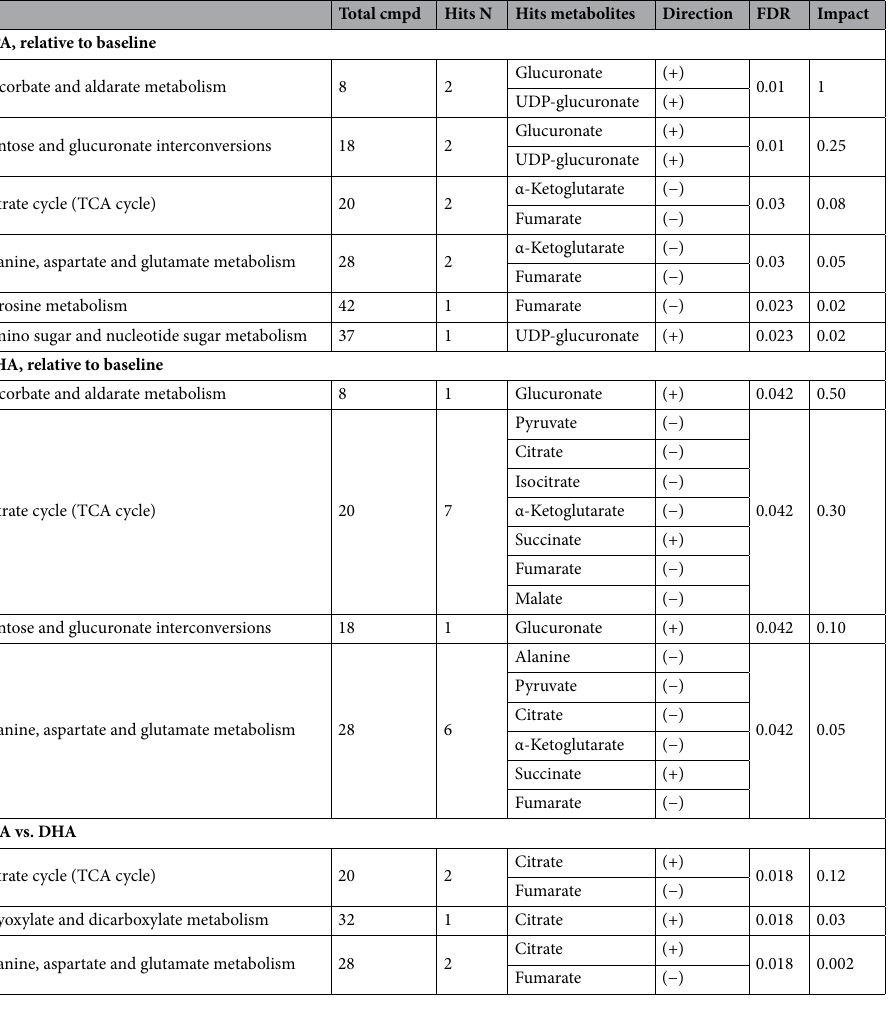
Table 4. Top pathways affected by EPA and DHA supplementation. Significant pathways (FDR < 0.05) with impact scores greater than 0 are